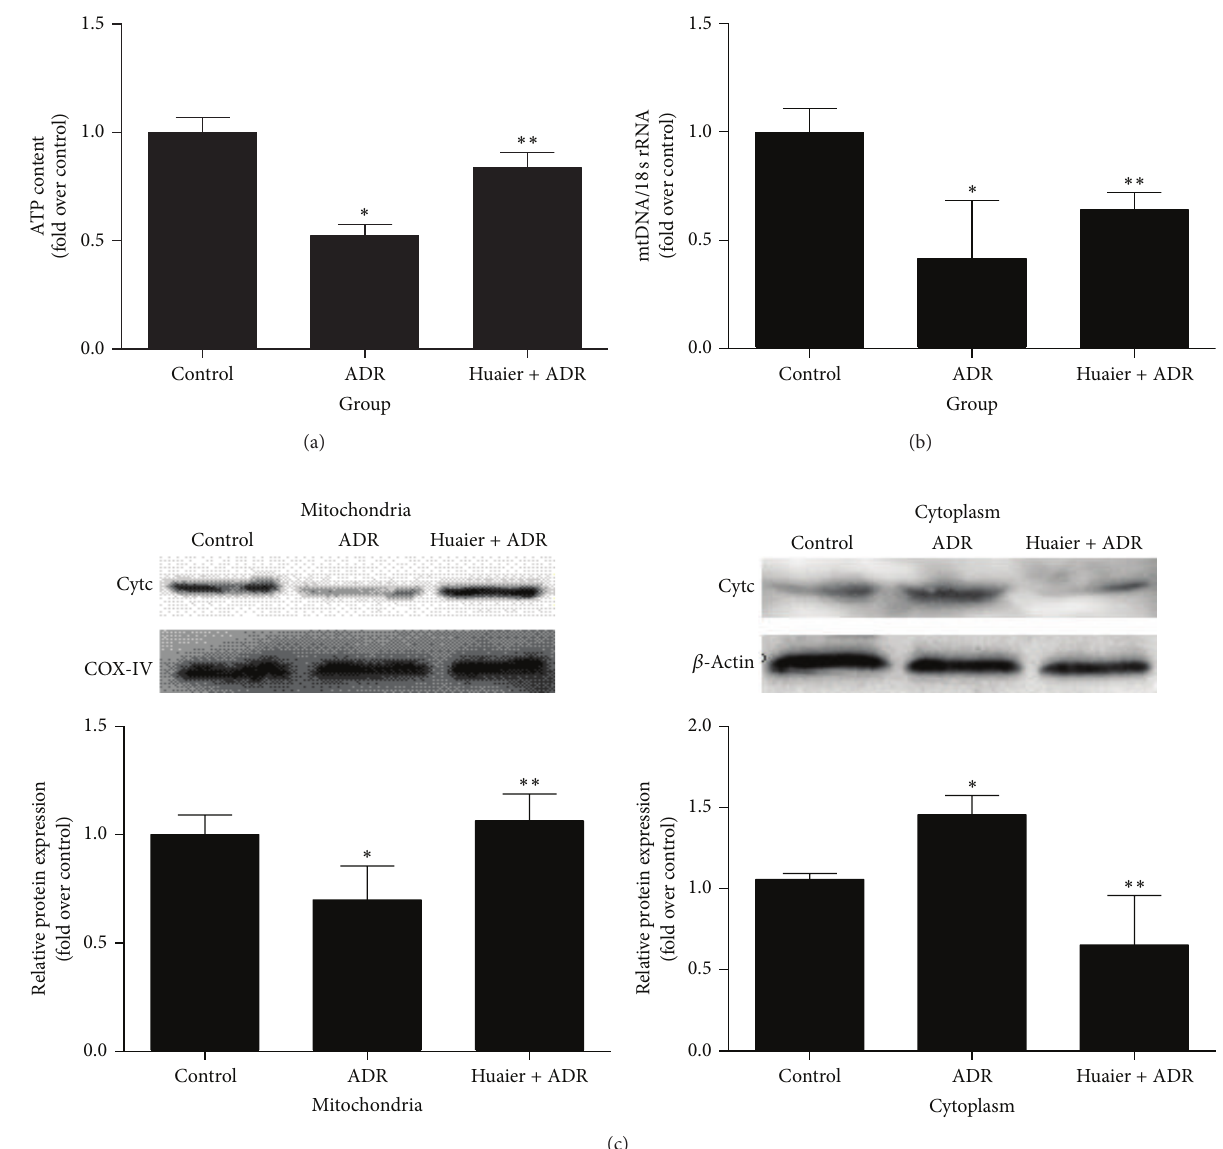
Figure 4: Huaier ameliorated ADR-induced mitochondrial dysfunction in rats. (a) ATP content. (b) Real-time PCR analysis of mtDNA copy number. (c) Western blot analysis of mitochondrial and cytosolic cytochrome 𝑐 . Upper: representative immunoblots. Lower: densitometric analysis. Data are expressed as the means ± SD ( 𝑛 = 6 ). ∗ 𝑃 < 0.05 versus control. ∗∗ 𝑃 < 0.05 versus ADR